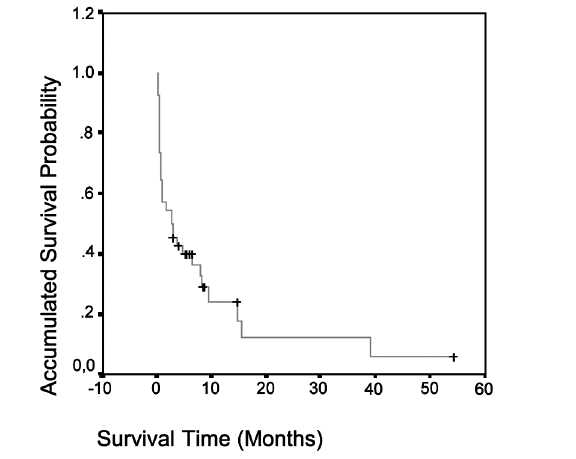
Figure 1 – Survival of patients with urogenital neoplasias within a 54-month period.